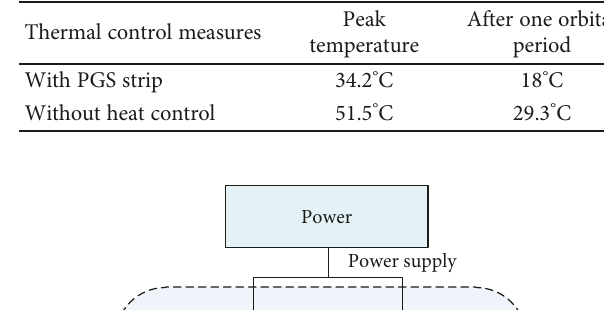
Table 4: Comparison of the control measures.